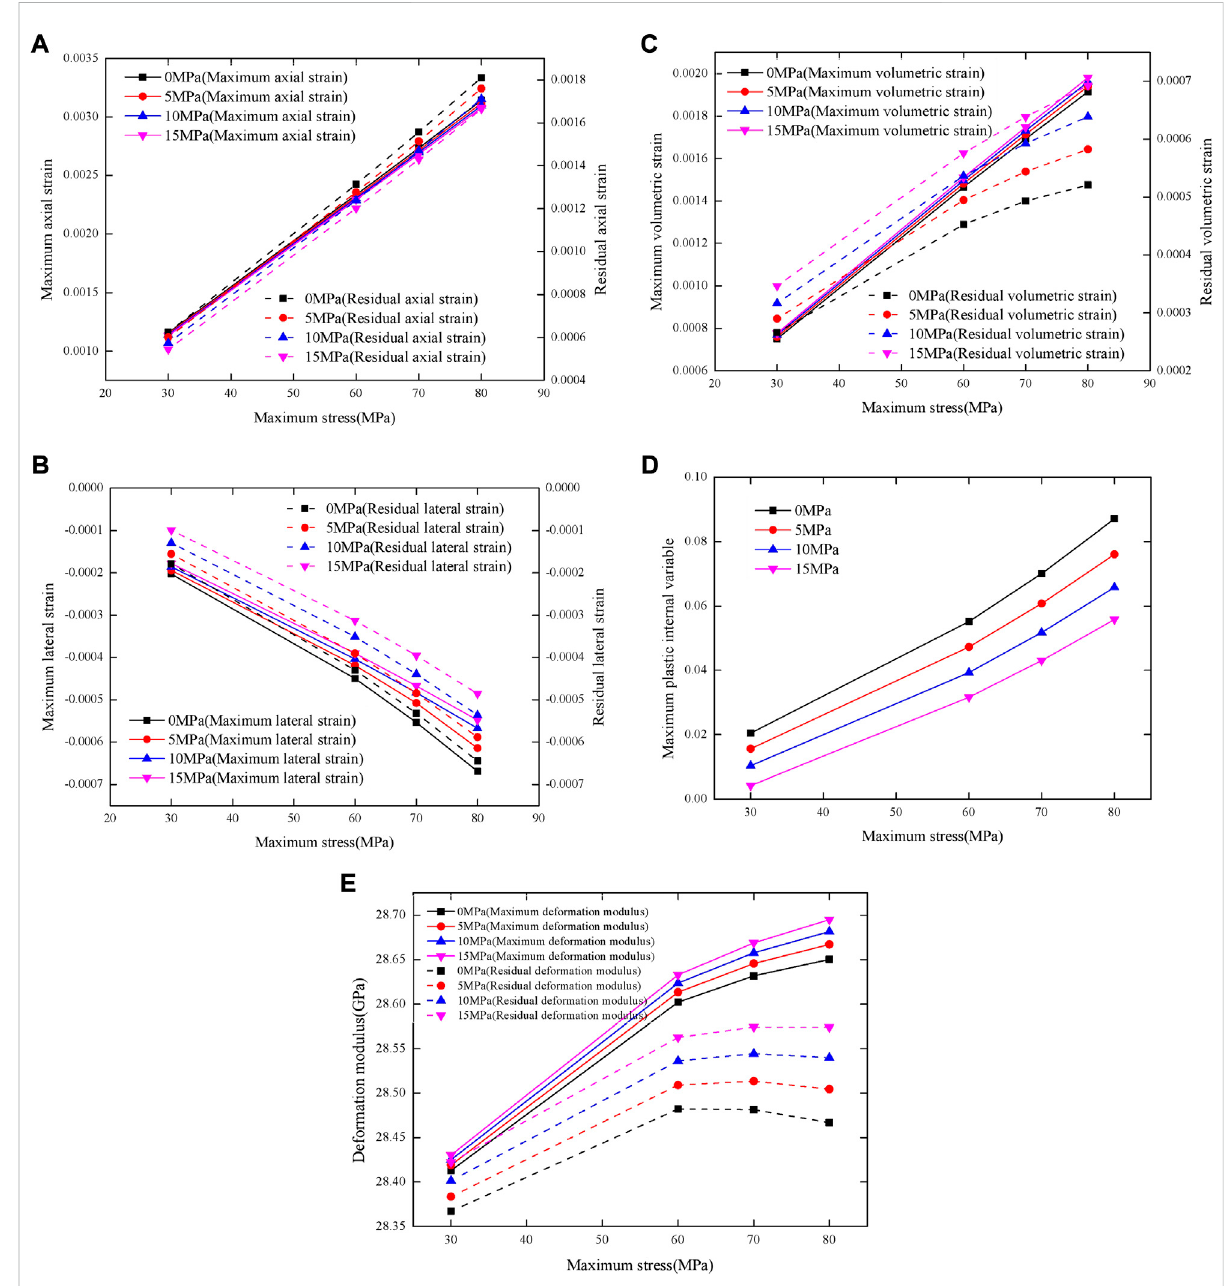
FIGURE 10 The variation in deformation properties of the rock with maximum stress under Kobe seismic load with different con fi ning pressures: (A) Axial strain; (B) Lateral strain; (C) Volumetric strain; (D) Maximum plastic internal variable; (E) Deformation